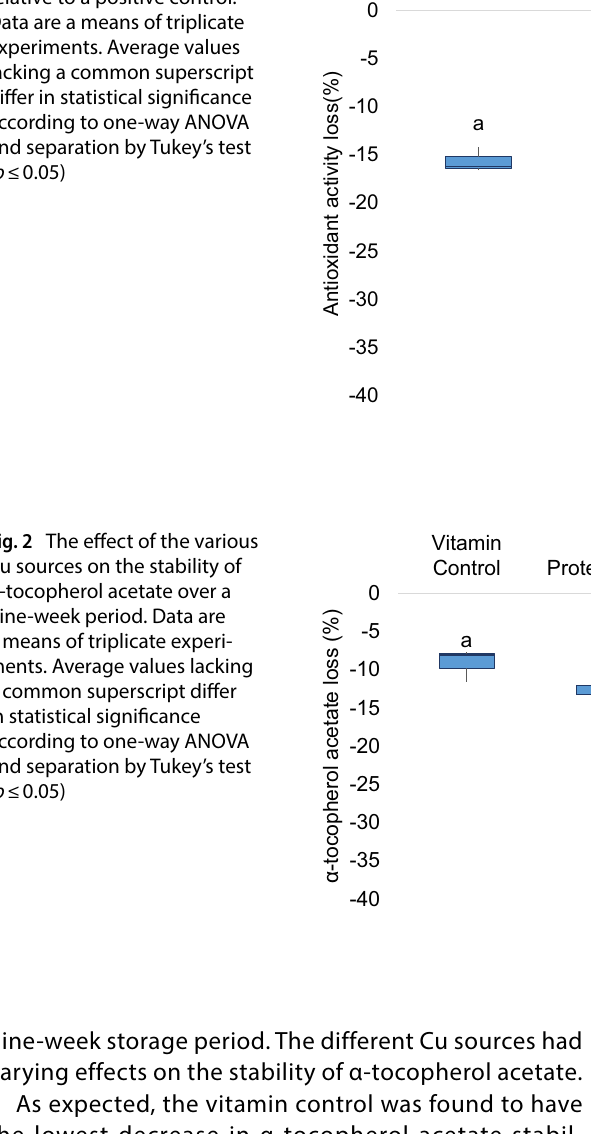
Fig. 1 Impact of Cu source on the antioxidant activity of BHT relative to a positive control. Data are a means of triplicate experiments. Average values lacking a common superscript differ in statistical significance according to one-way ANOVA and separation by Tukey’s test ( p ≤ 0.05)